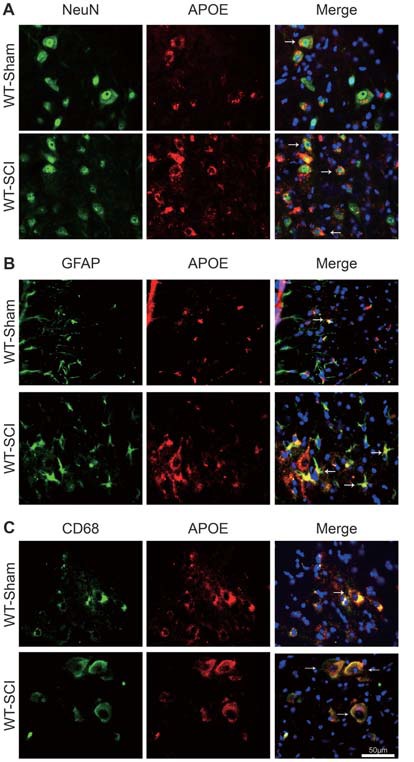
Expression of APOE protein in neurons, astrocytes, macrophages/microglia following SCI. (A–C) The cellular localization of APOE was observed by double immunofluorescent staining of APOE (red) with NeuN, GFAP, CD68 (green) and DAPI (blue), respectively. Four transverse sections were taken at ±1000 μm from rostral and caudal to the injury site per spinal cord (N = 6 per group, white arrows: APOE-positive neurons, astrocytes and macrophages, Scale bars = 100 μm).